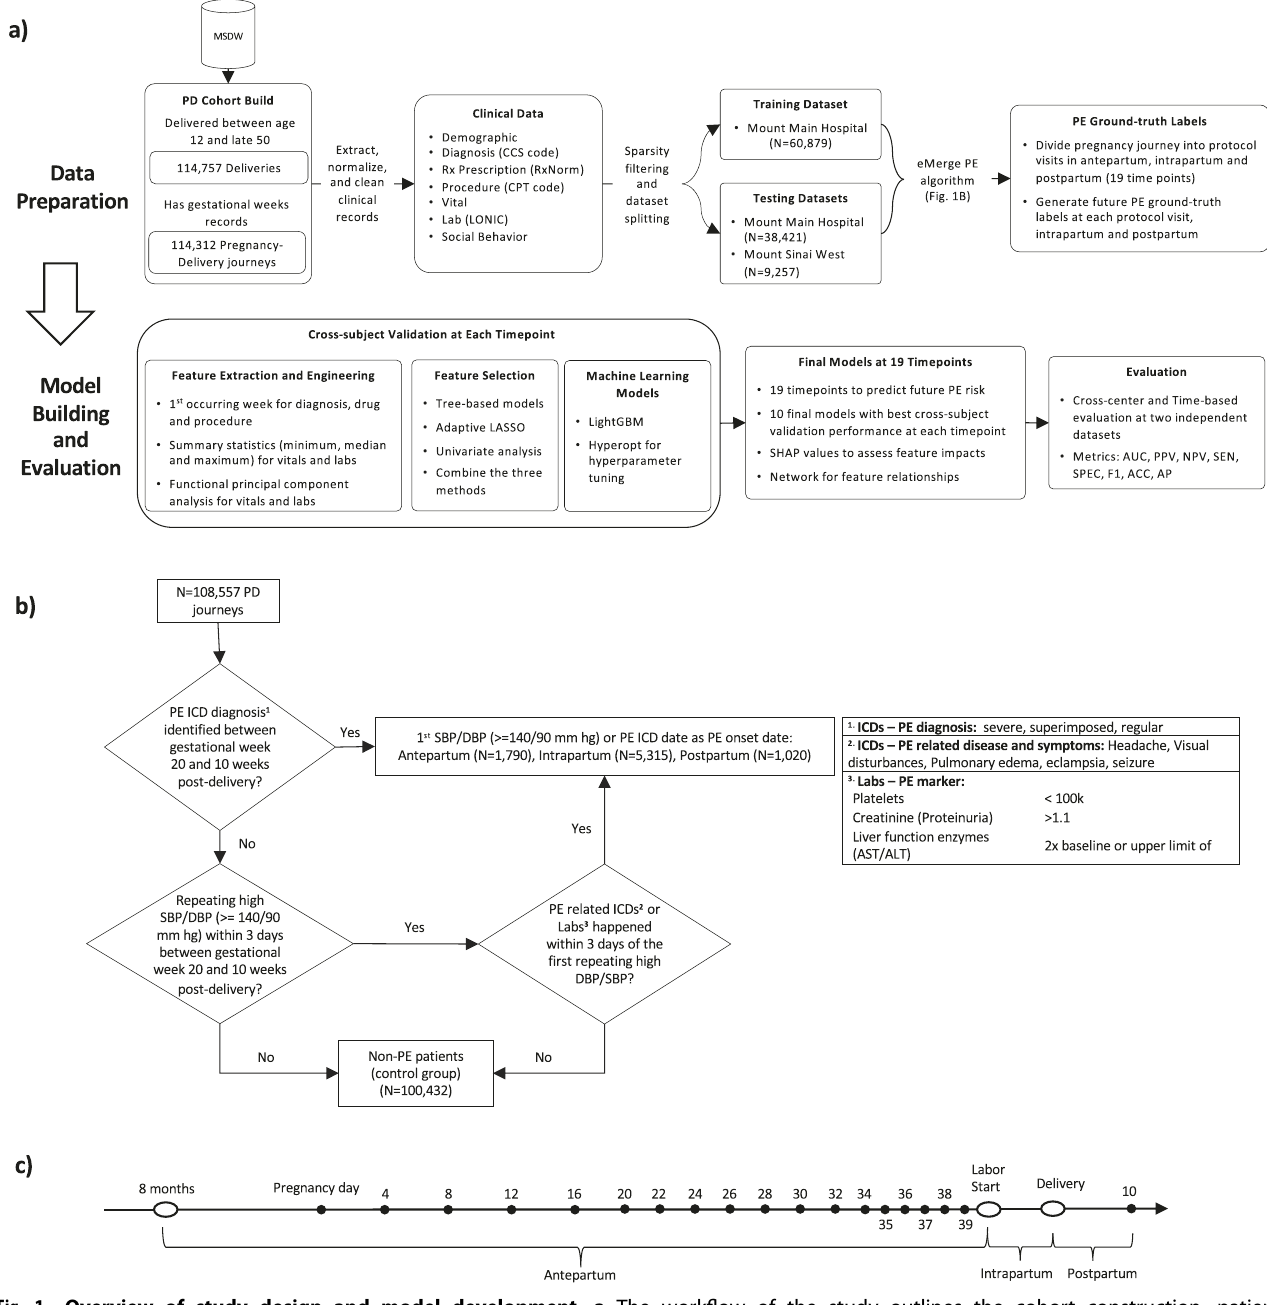
Fig. 1 Overview of study design and model development. a The work fl ow of the study outlines the cohort construction, patient characteristics extraction, dataset splitting into training and testing datasets (including subdivision into antepartum, intrapartum, and postpartum), feature engineering, feature selection, machine learning models (cross-subject validation) and fi nal evaluation. b The proposed eMerge algorithm to identify preeclampsia (PE) patients to construct the binary prediction problem. c The schematic of 19 timeline models including: monthly models, weeks 4 – 20; biweekly models, weeks 22 – 34; weekly models, weeks 35 – 39; intrapartum and postpartum